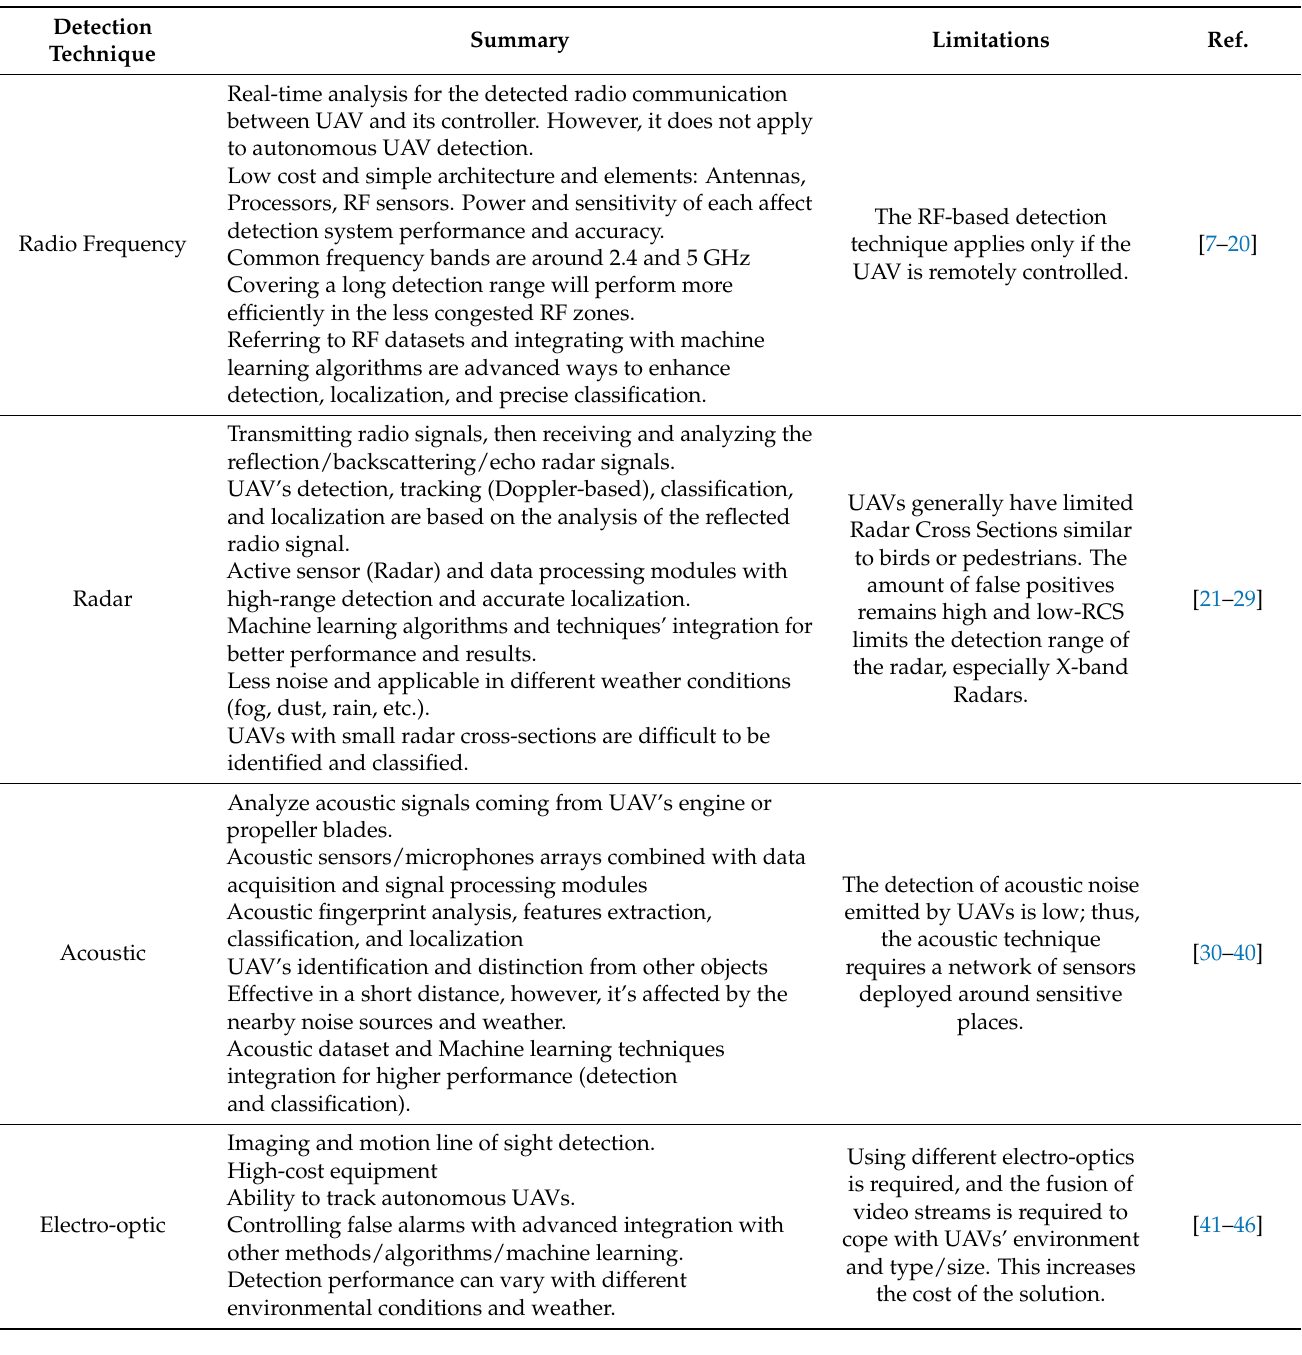
Table 6. Summary of all reviewed UAV detection